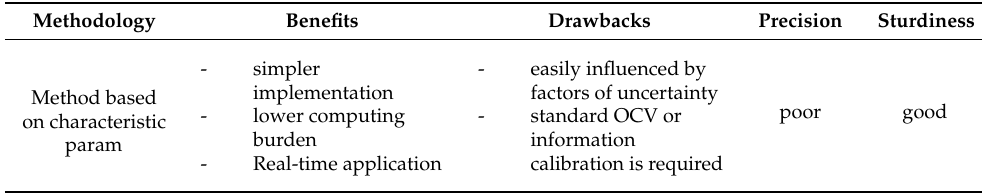
Table 1. SOC estimation methods: benefits, drawbacks, accuracy, and robustness. Reprinted from Refs. [35,36].